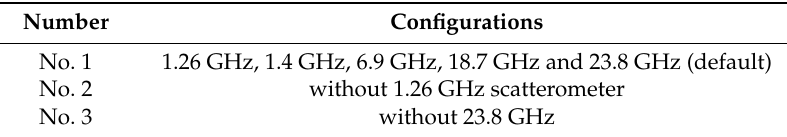
Table 2. The different instrument configuration selections.